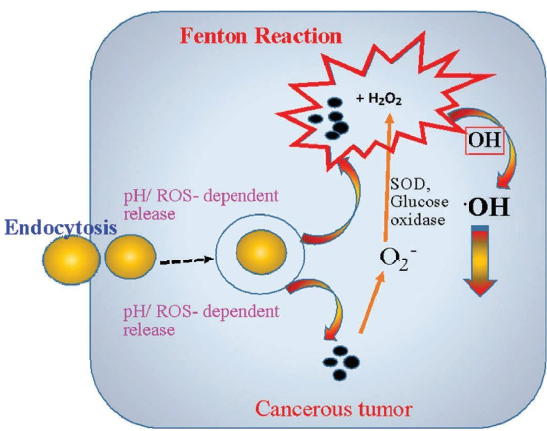
Figure 6: Mechanism of ROS generation by